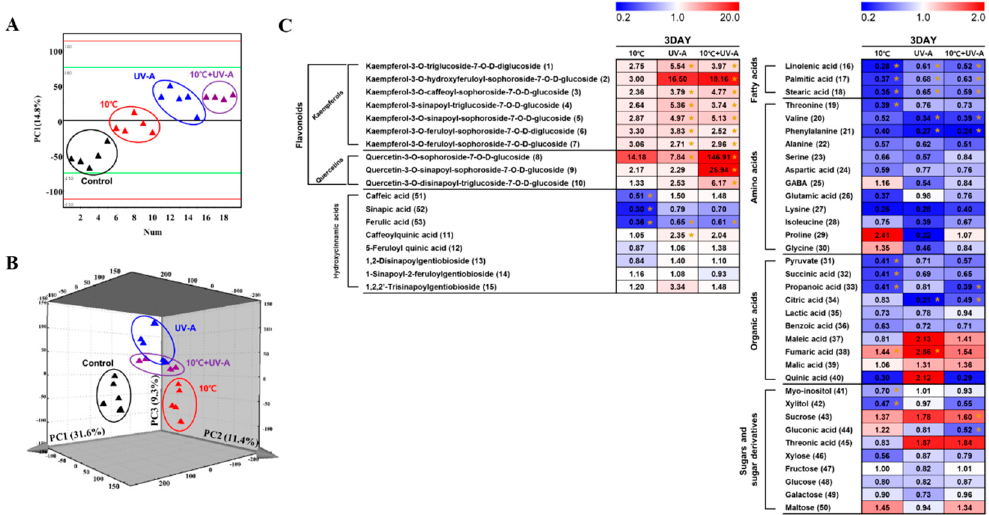
Figure 5. PCA score plots derived from UPLC–Q–TOF–MS ( A ) and GC–TOF–MS ( B ) data for kale leaves after 3 days of 10 ◦ C, UV-A, and combined treatments. ( C ) Heat map representation of the relative abundance of significantly discriminant metabolites (VIP > 0.7) based on the orthogonal partial least squares-discriminant analysis (OPLS–DA) model (Supplementary Figure S2). The values represent the fold change with respect to the control. Asterisks indicate significant di ff erences ( p -value < 0.05) between the control and each treatment.